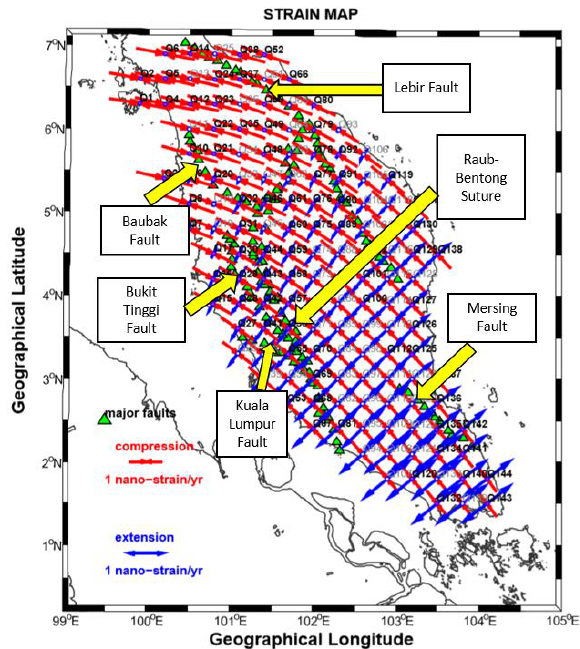
Figure 13. Strain rate map over Peninsular Malaysia in 2012.